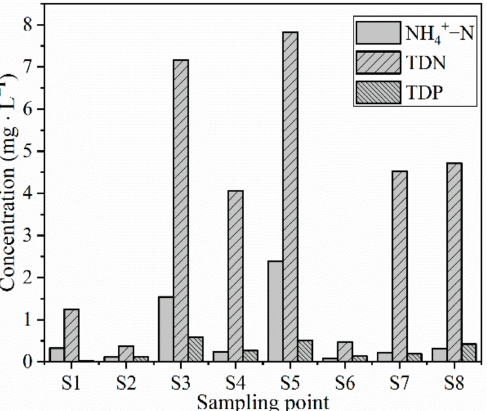
Figure 2. Nutrient concentration of overlying water at sampling point of the Yitong River.